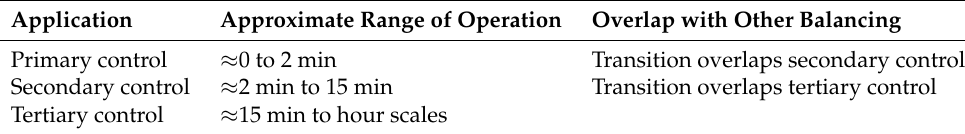
Table 2. Activation of the reserves after an